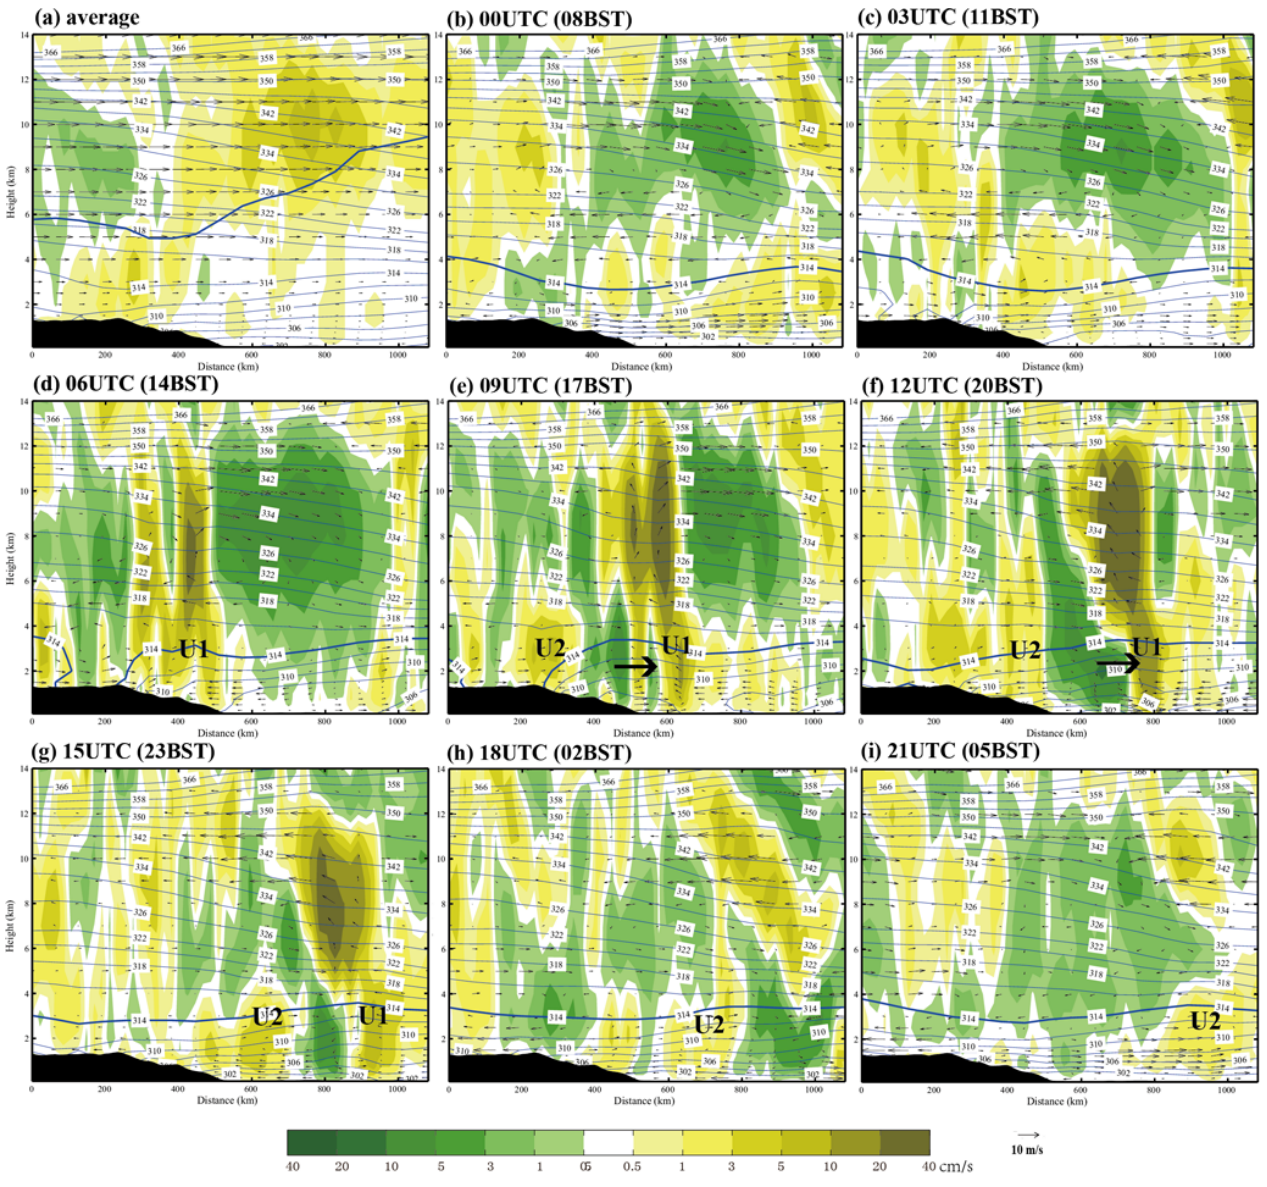
Fig. 8. (a) Height–distance cross section of daily mean potential temperature (solid lines, K), vertical velocity (shaded, cms − 1 ) and the mean circulation vectors (horizontal wind component along the northwest–southeast cross section and 100 times the vertical velocity) averaged over ABEF from CNTL. The thick blue line shows where the northwesterly wind is equal to 12ms − 1 . (b–i) As in (a) except that the vertical velocity and circulation vectors are the diurnal perturbations from the daily mean (potential temperature contours are of their full values). The black shading represents topography. The thick blue lines show that the potential temperature value is equal to 314K in (b–i) . The arrows show the pressure gradient force (PGF). U1 and U2 represent the main updraft and the secondary updraft,